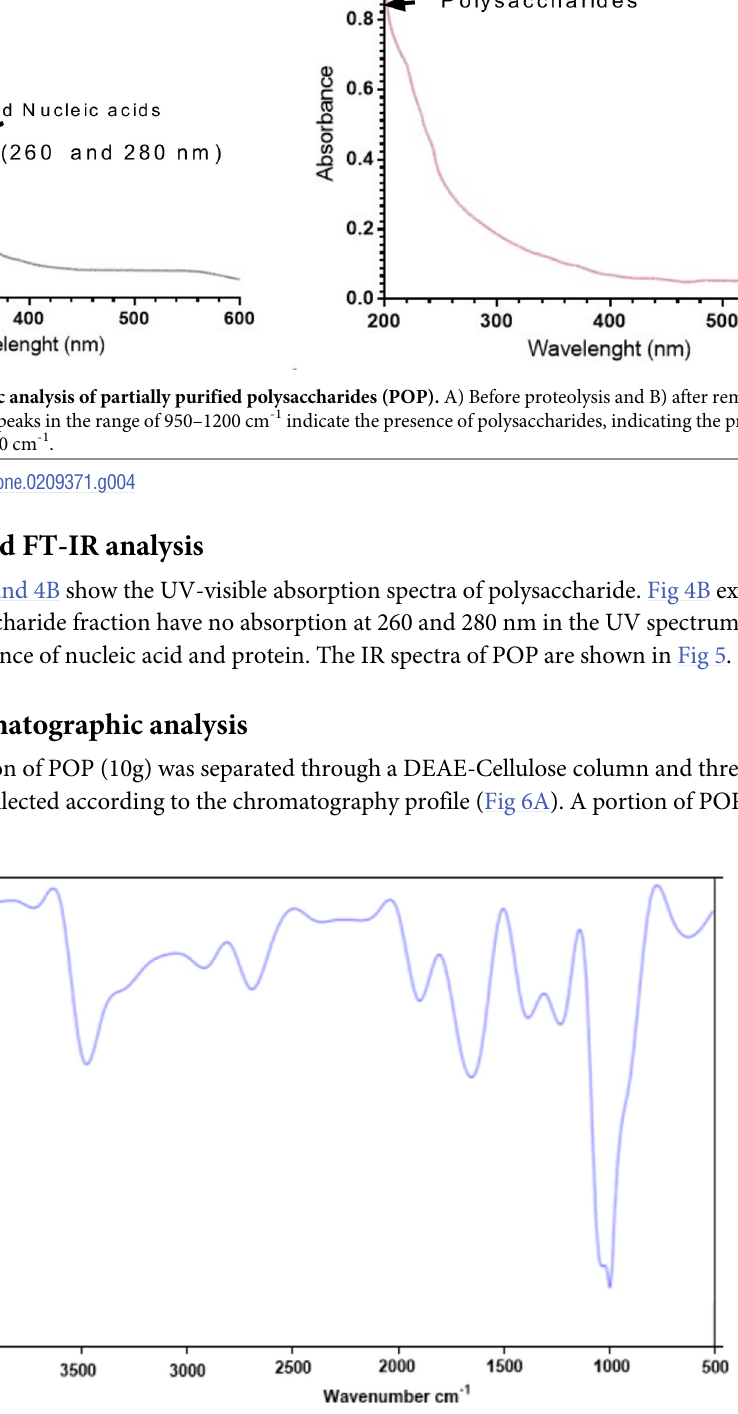
Fig 5. FT-IR spectral analysis of the polysaccharide (POP). The spectra indicate a noticeable C-H stretching and bending vibration absorption in the range of 2929–2939 cm -1 , which are characteristic peaks of the polysaccharide[29]. In the marked region, the peak in the region of 1230 cm -1 is due to C-C stretching vibration and the peaks towards 1100 cm -1 suggesting that the peak was related to the starching vibration of